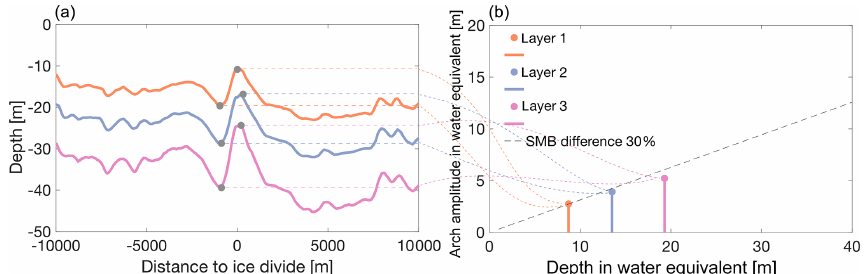
Figure 6. Panel (a) shows the depth of the tracked IRH from the GPR data (Fig. 3) across the LIR. Panel (b) shows the arch amplitudes around the ice divide (in water equivalent) versus the depth of the arches. The dashed line shows the theoretical size of the arch amplitudes with depth for an SMB difference of 30%.